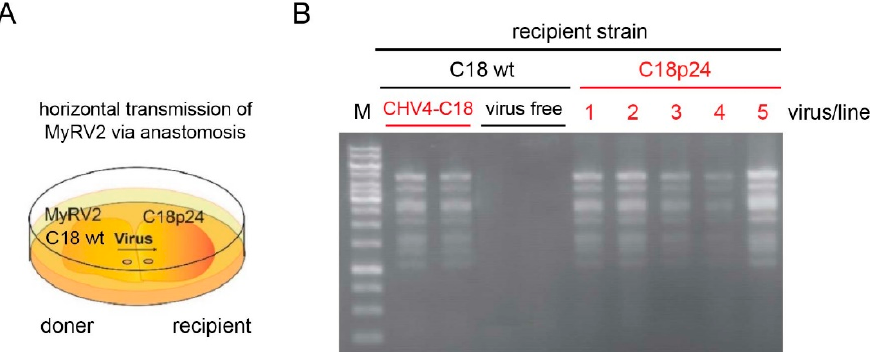
Figure 6. Transgenic expression of CHV4-C18 p24 in recipient C. parasitica strains facilitates horizontal transmission of MyRV2 via anastomosis. Non-transgenic donor isolates containing MyRV2 (left side of panel A ) were co-cultured on PDA with CHV4-C18 p24 transformants (C18p24) as recipients (right side of panel A ), or with virus-free (C18-VF) and CHV4-C18-infected (C18/CHV4) recipients as controls. Following anastomosis, subcultures were obtained from the recipient side and tested for MyRV2 infection by conventional dsRNA extraction and agarose gel electrophoresis (panel B ).